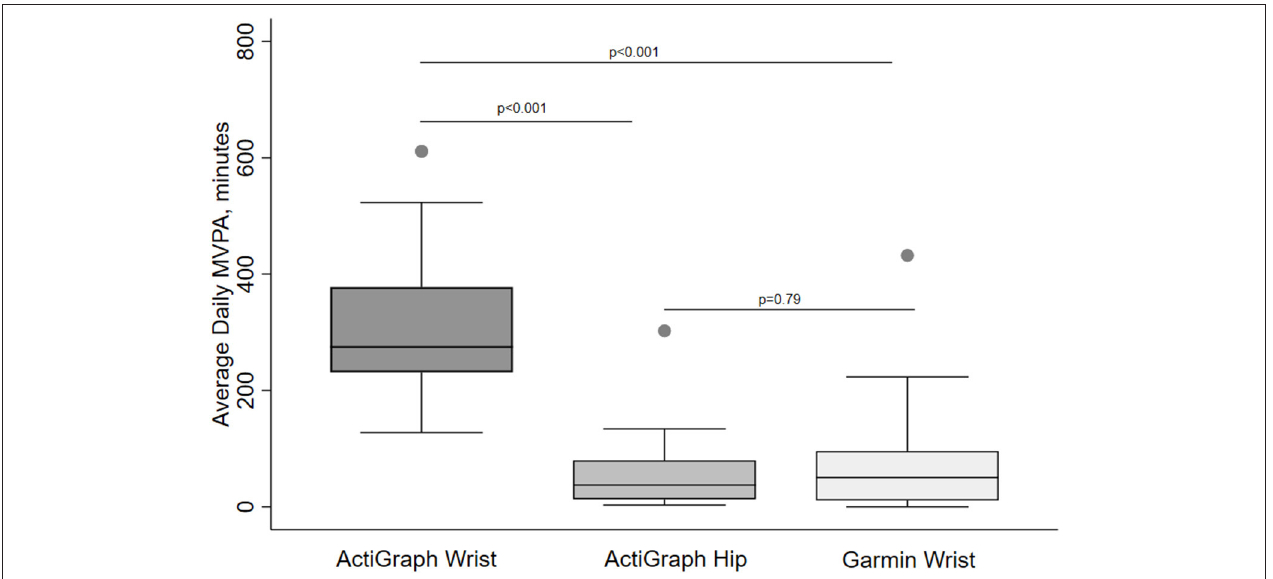
FIGURE 2 | Daily minutes of moderate to vigorous physical activity (MVPA) in older adults collected by different activity devices and wear locations. MVPA is defined by > 1,924 VM counts/min (ActiGraph) or Garmin proprietary definition. Pair-wise comparisons were tested by the Signed Rank test.